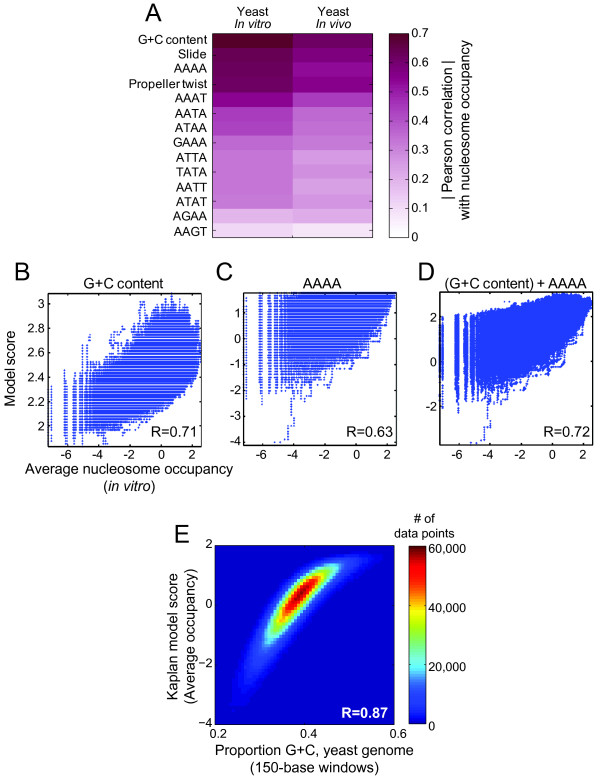
Correlation of each of the 14 features with nucleosome occupancy. (A) Graphic illustration of the correlation of each of the 14 sequence features with nucleosome occupancy in vitro and in vivo across the yeast genome (data from Kaplan et al.[8]). (B-D) Scatter plots showing performance of linear models on test set using only G+C content (B), AAAA occurrence (C), or both (D) as inputs. (E) Kaplan model score vs. proportion of G+C over all 150 bp tiling windows in the yeast genome.